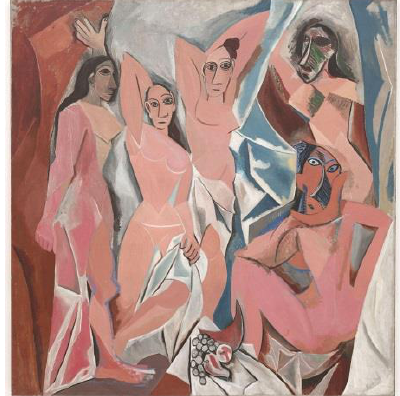
Fig. 25 Les demoiselles d’Avignon, (Picasso, 1907)